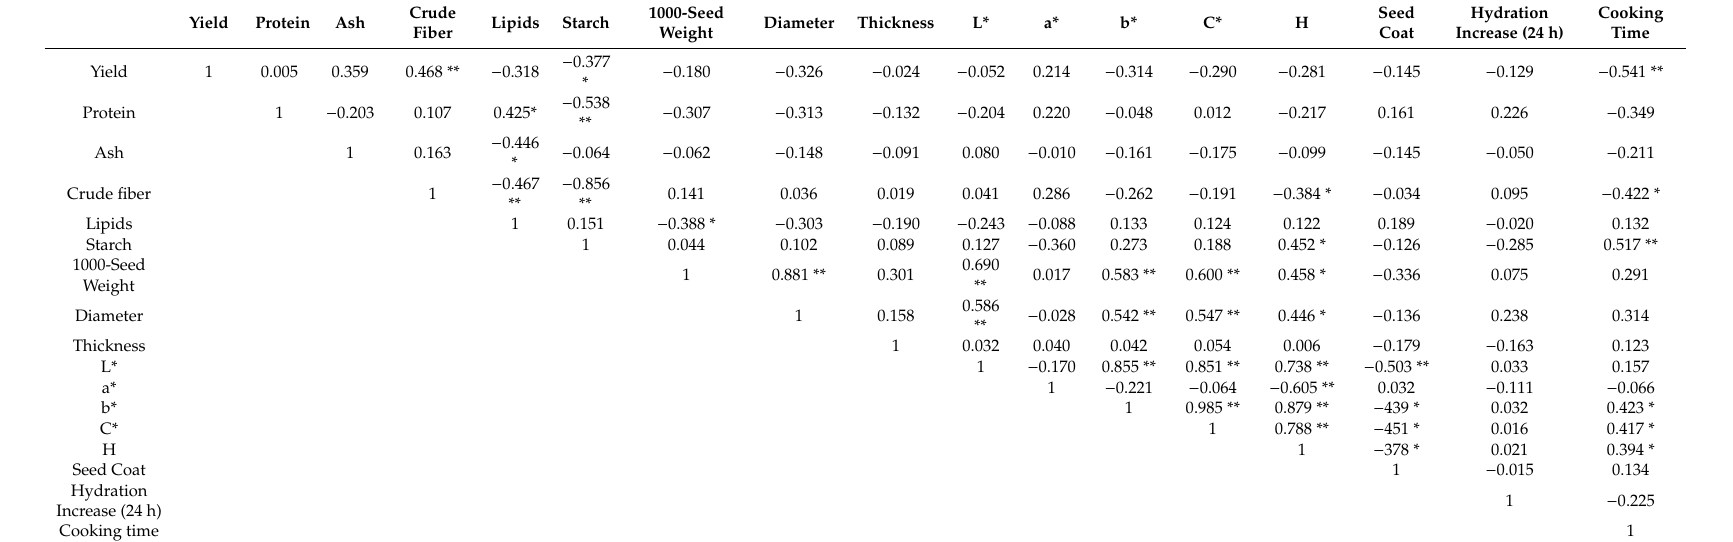
Table 7. Correlation between agronomical, morphological, physicochemical nutritional quality traits and seed coat